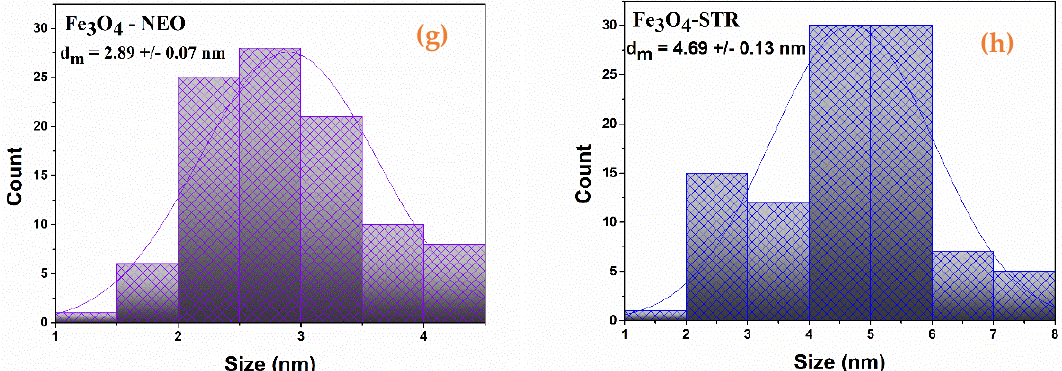
Figure 2. TEM images of ( a , c ) Fe 3 O 4 @NEO, ( b , d ) Fe 3 O 4 @STR; SAED patterns of ( e ) Fe 3 O 4 @NEO, ( f ) F e3 O 4 @STR nanoparticles; histograms of ( g ) Fe 3 O 4 @NEO, ( h ) F e3 O 4 @STR nanoparticles.